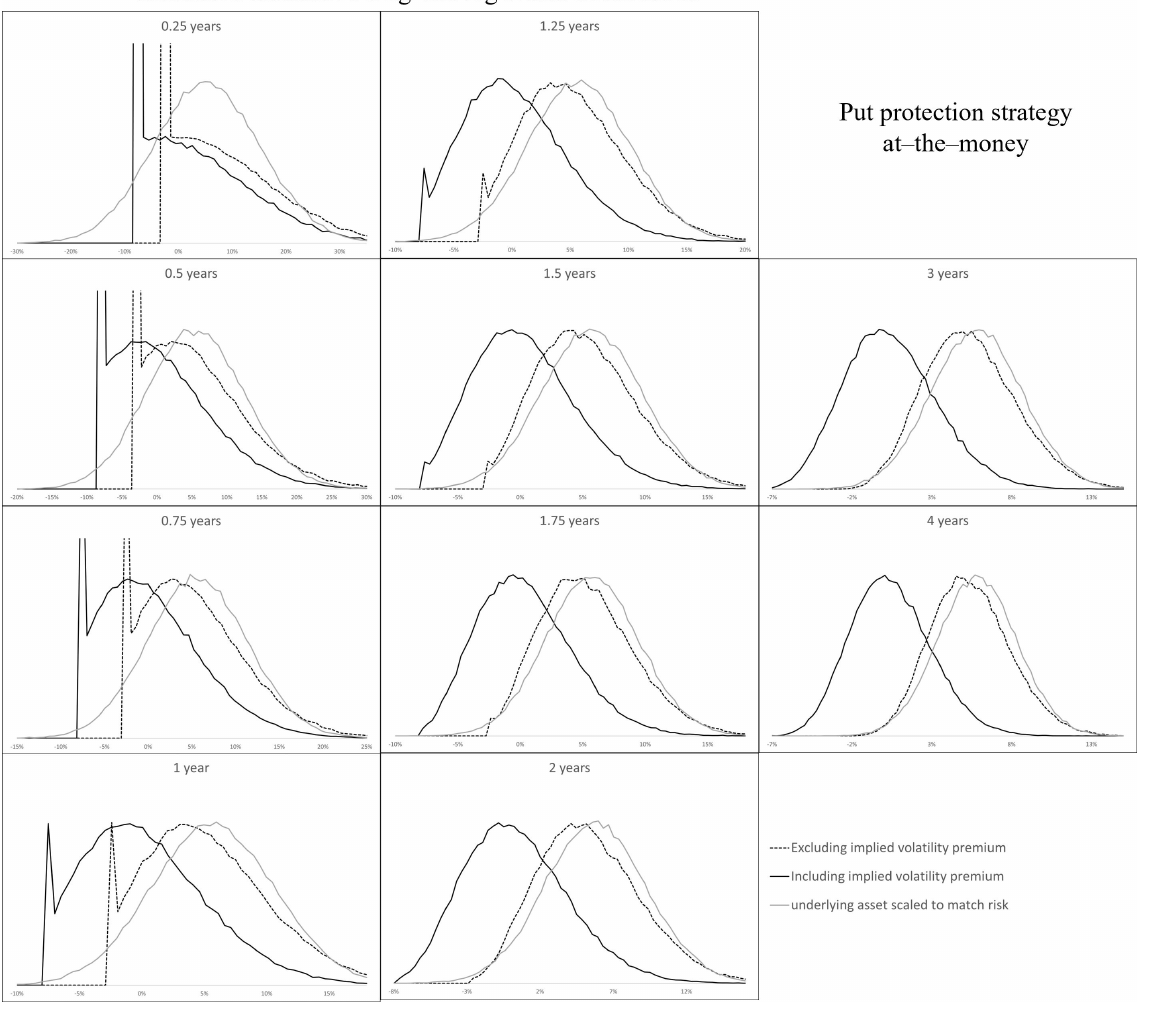
Figure 21. Simulations of the long-run returns of an underlying asset overlaid with a quarterly at-the-money put protection strategy over investment horizons of 1 / 4 year, 1 / 2 year, 3 / 4 year, 1 year, 1 1 / 4 years, 1 1 / 2 years, 1 3 / 4 years, 2 years, 3 years, and 4 years. The dotted line assumes the implied volatility is equal to the underlying asset volatility. The solid line includes the implied volatility premium in the price of the options. The gray line shows the long-run returns of a portfolio consisting of the risk-free asset and the underlying asset weighted to have the same risk as the option